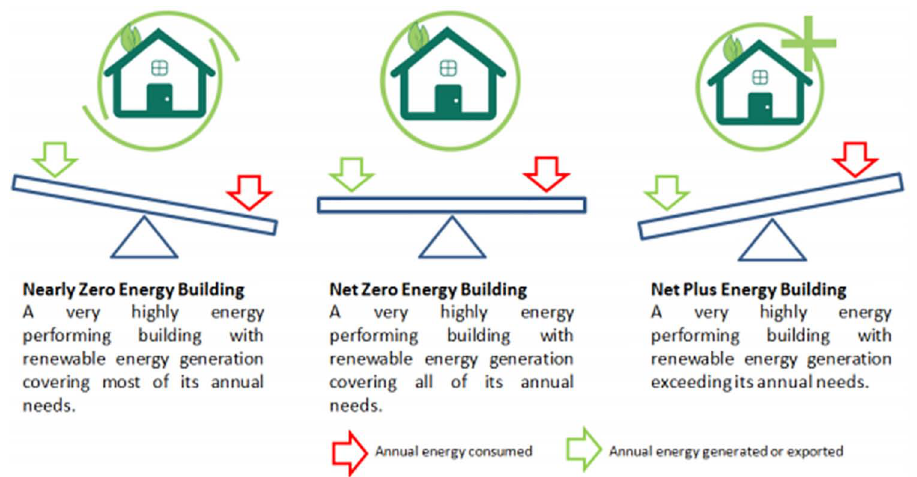
Figure 4. Different Definitions of Nearly, Net and Net Plus Energy Buildings (Source: Fayyad and John, 2017).